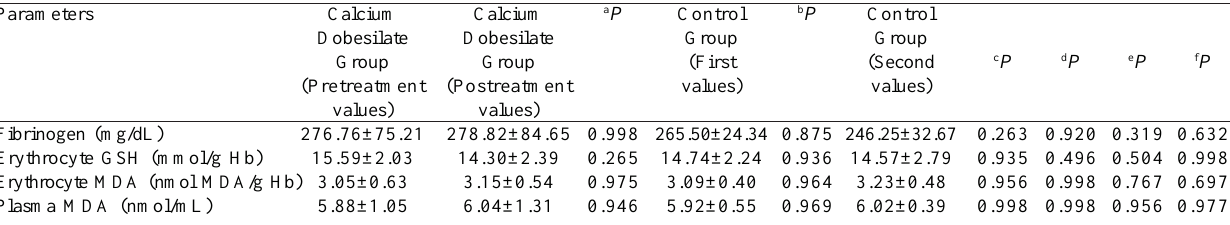
Table 3. Fibrinogen, erythrocyte GSH, erythrocyte MDA and plasma MDA values before and after calcium dobesilate treatment in the calcium dobesilate group and first and second values after three months in the control group.